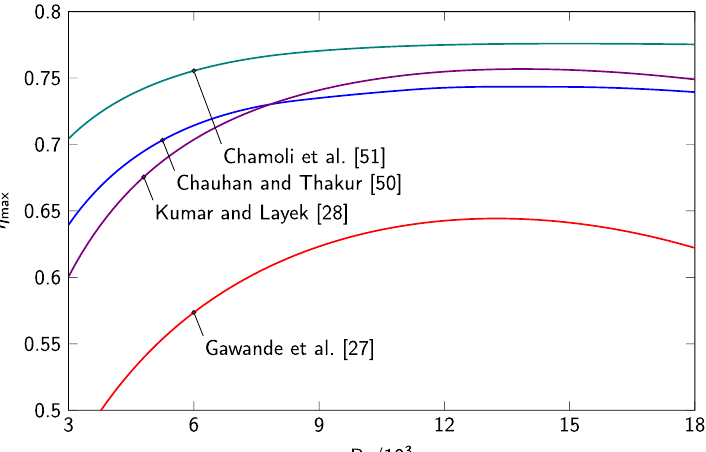
Figure 19. Relationship between η max and Re for absorber plates with other obstacle types and ˙ G = 1000Wm − 2 .